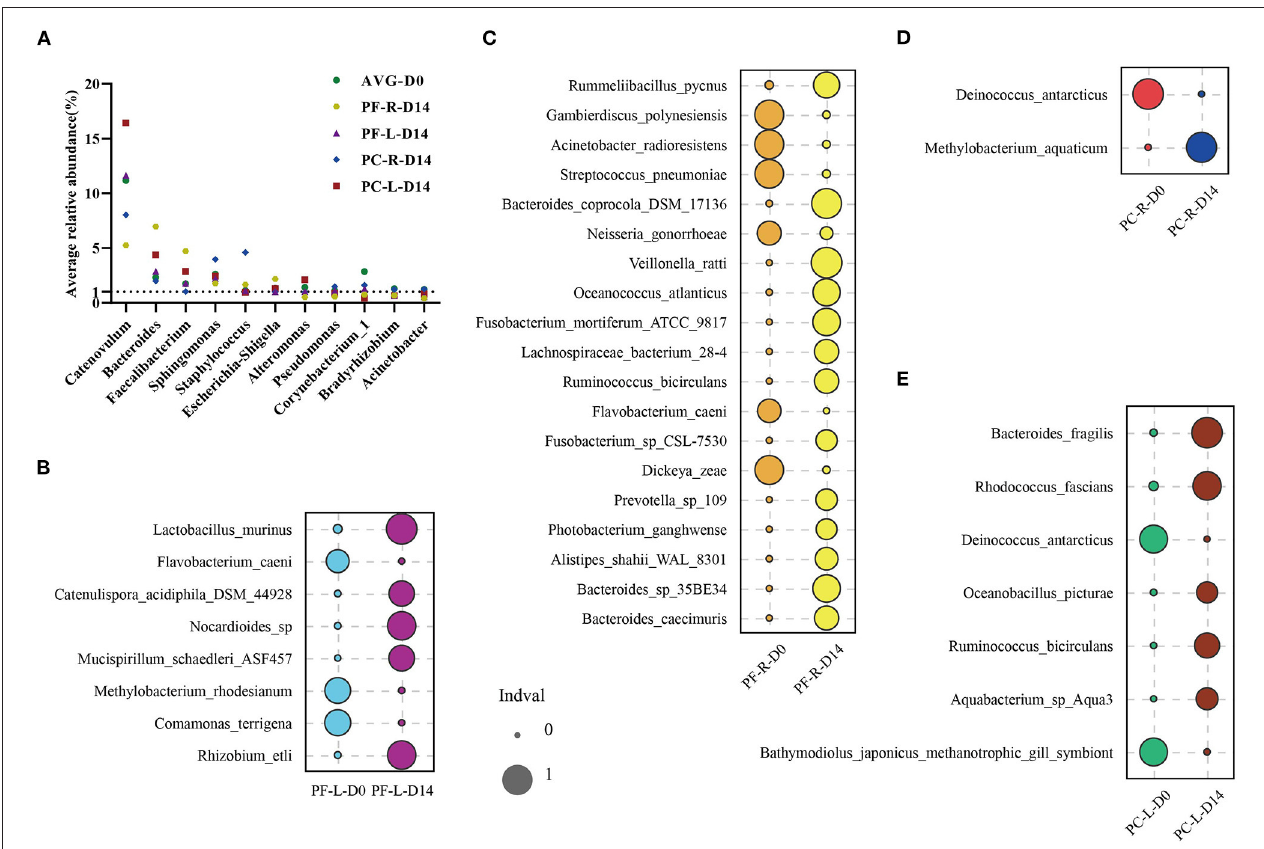
FIGURE 5 | Indicator analysis of repeated samples from the preservative-free (PF) and preservative-containing (PC) groups. (A) Changes in the average abundance of 11 “core” bacterial genera in each group before and after intervention. Indicator analysis of (B) PF-L group, (C) PF-R group, (D) PC-R group, and (E) PC-L